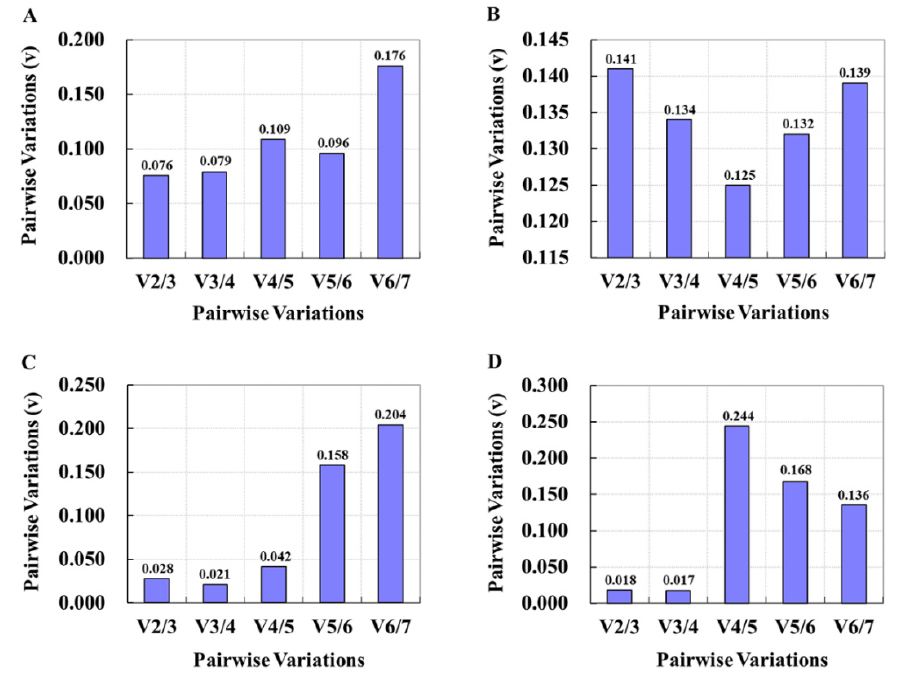
Figure 8. Optimum pairs of housekeeping gene candidates necessitated for normalization in GPS cells under stimulation with Poly I:C for 2 ( A ), 4 ( B ), 8 ( C ) and 12 h ( D ) according to geNorm analysis. The optimal number of reference genes depends on the V n/n+1 value via geNorm analysis; moreover, the value is popularly less than 0.15.